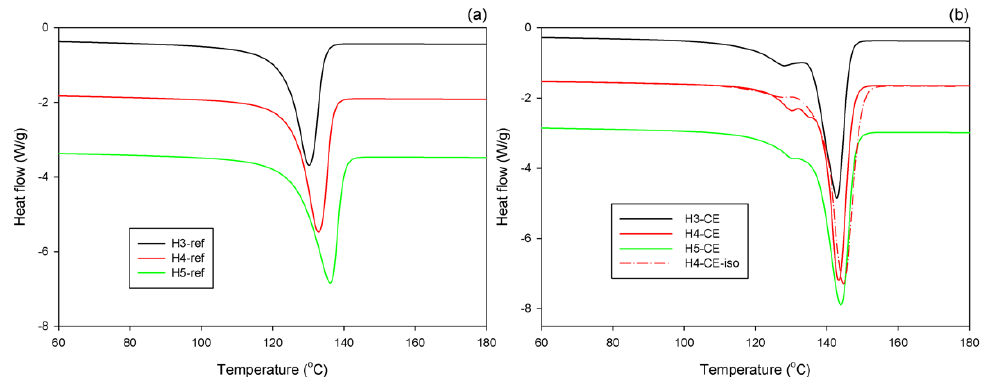
Figure 2. DSC melting thermograms of the reference samples, crystallized at conventional conditions ( a ), and CEPE samples, crystallized under pressure of 480MPa ( b ). Table 2. Characteristics of the reference and CEPE samples of polyethylene derived from DSC and SEM results.